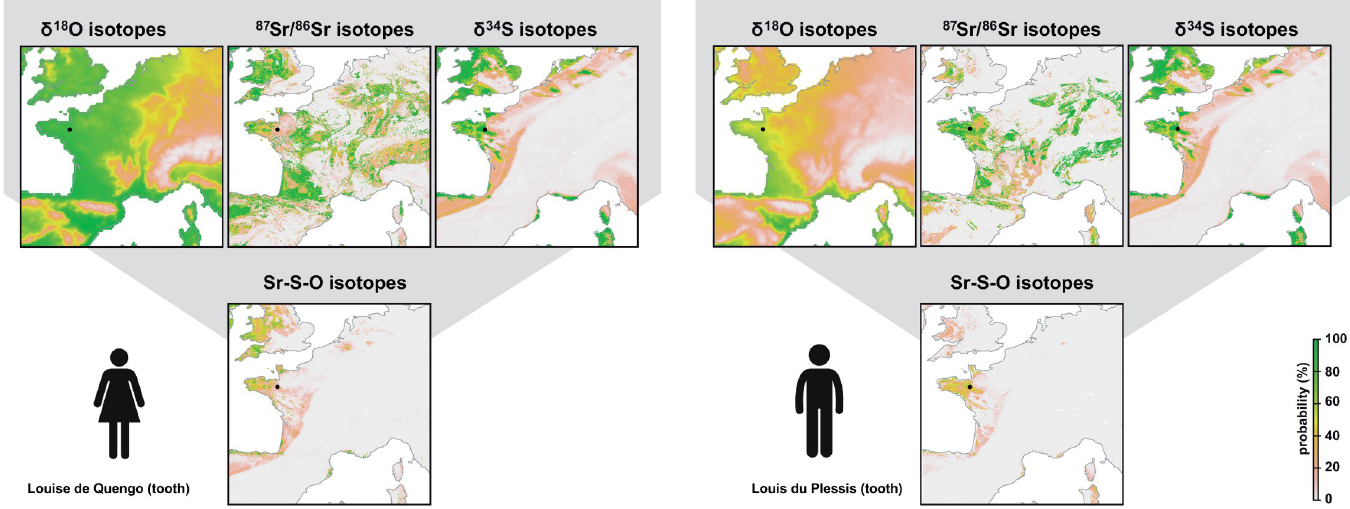
Fig 5. Maps showing the probability of origin of Louise de Quengo and Louis de Plessis based on single and triple isotopes geographic assignments. To generate these figures the script is available in S1 and S2 Scripts.